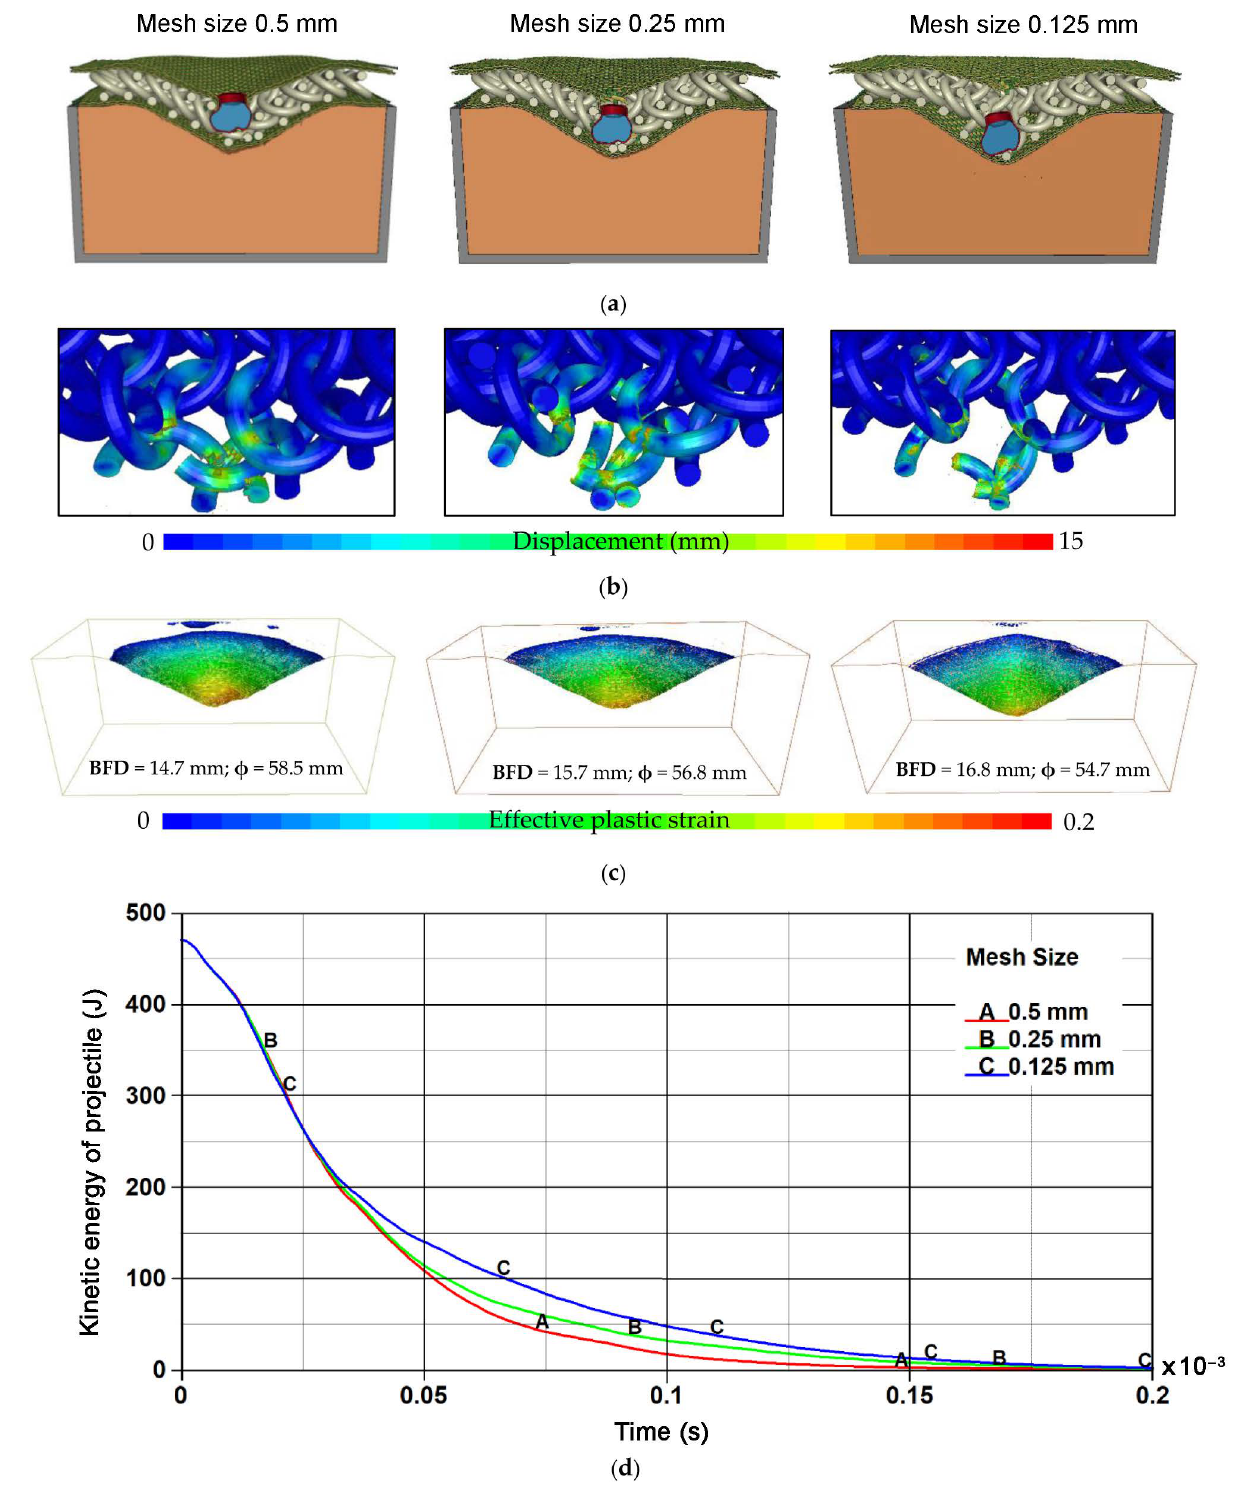
Figure 18. Results of simulations performed in the mesh sensitivity study: ( a ) final deformation; ( b ) distribution of effective plastic strain in the titanium structure; ( c ) shape of the hollow in the ballistic clay and ( d ) plot of the projectile energy against time.